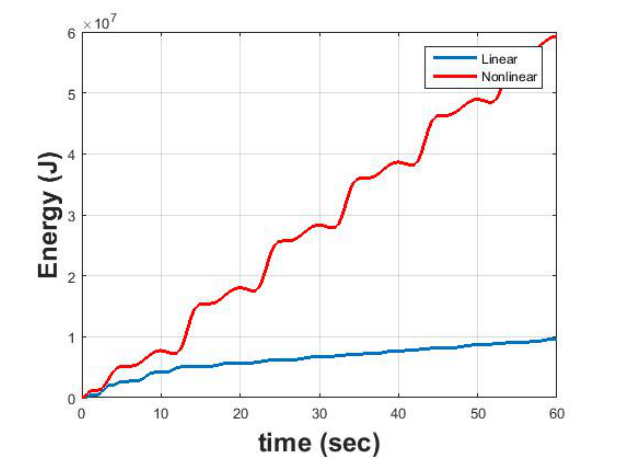
Figure 8. Comparison between the linear and nonlinear WECs in a regular wave: energy extracted.